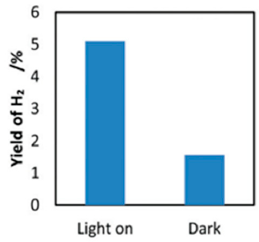
Figure 35. Yield of C 18 O after exchanging surface oxygen with ( a ) H 216 O and ( b ) H 218 O. Reprinted from [30]. Figure 36. Speculated mechanism of photocatalytic DRM using Rh/SrTiO 3 . Reprinted from [30]. To further investigate the photocatalytic DRM mechanism, Kushida et al. constructed a unique gas-phase photoelectrochemical system (Figure 37) [52]. They used yttria-stabi- lized zirconia (YSZ) pellets as an electrolyte to conduct oxygen ions inside. On both sides of the YSZ pellet, they deposited the Rh/YSZ photocatalyst, the target material for discus- sion. When using a powder photocatalyst, the redox reaction occurs at the powder, and